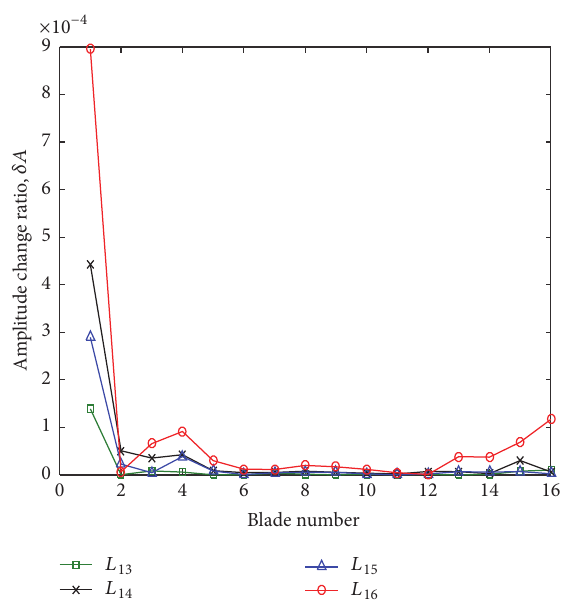
Figure 17: Vibration amplitude changes of MRBs under different 𝑙𝑐